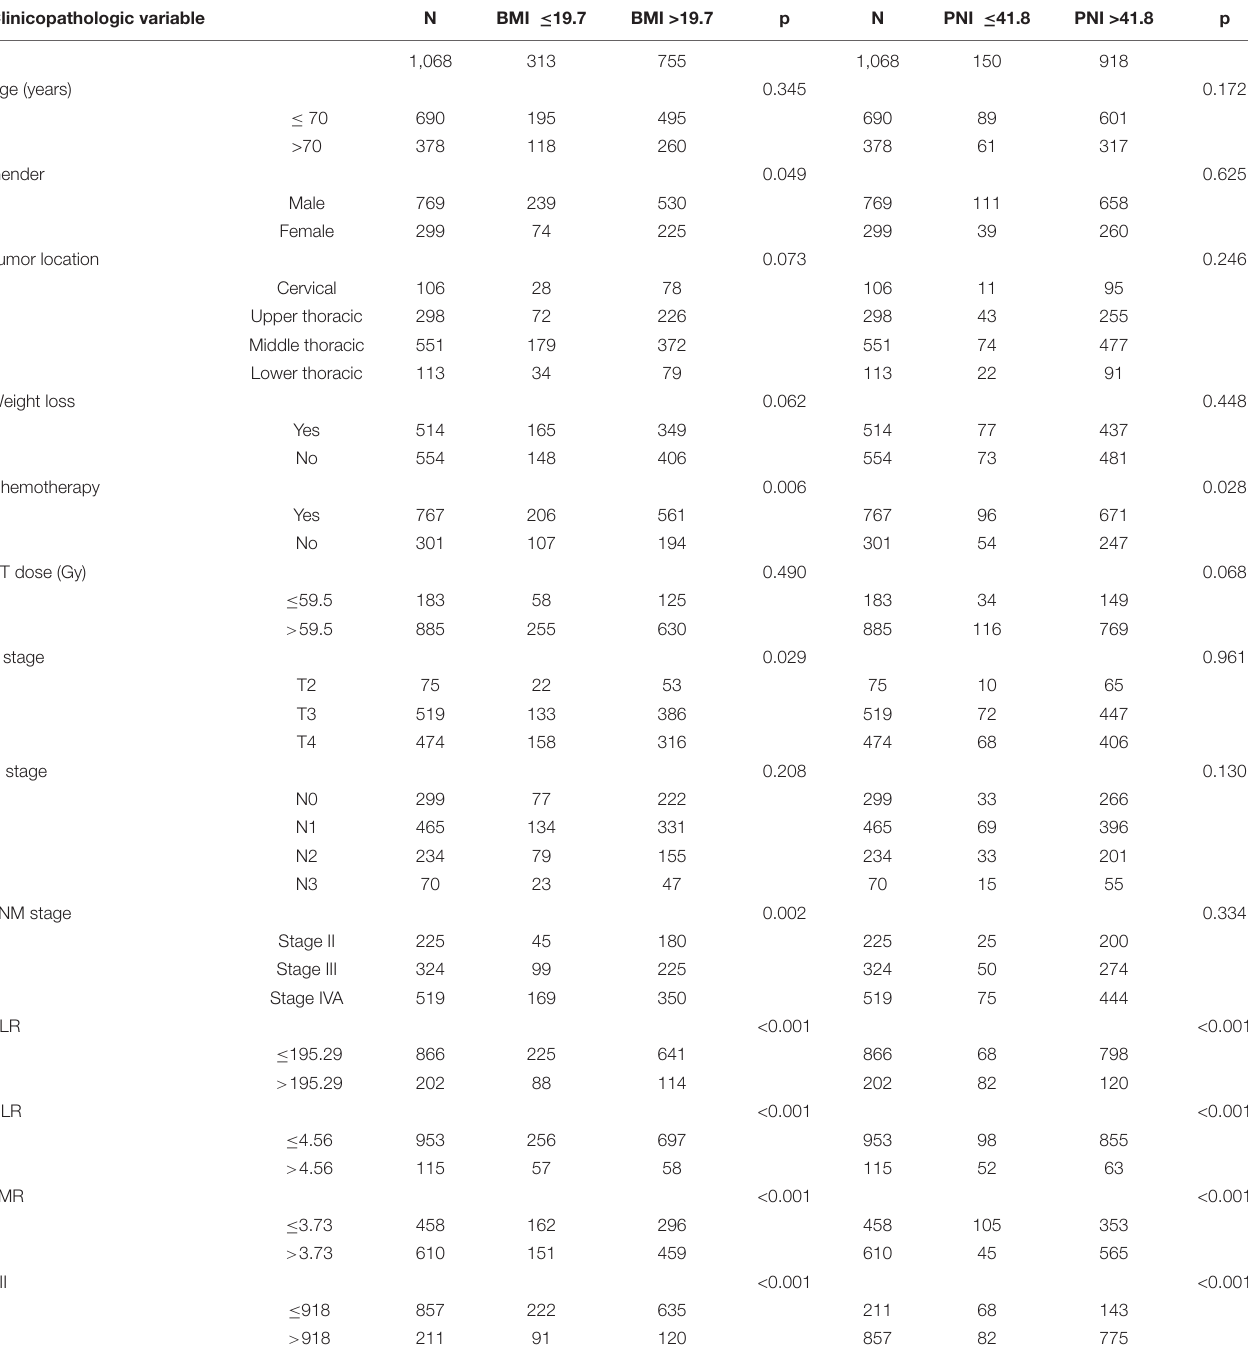
TABLE 1 | Patient characteristics of 1068 patients with locally advanced ESCC according to BMI and PNI. Clinicopathologic variable N BMI ≤ 19.7 BMI >19.7 PNI ≤ 41.8 PNI